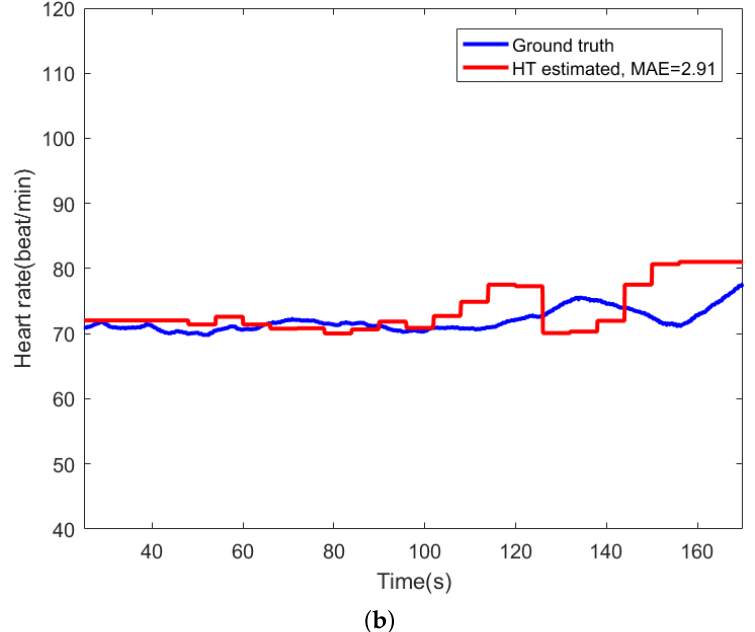
Figure 9. Comparison of heart rate estimation between AE-GMM and HT on subject no. 10. ( a ) Heart